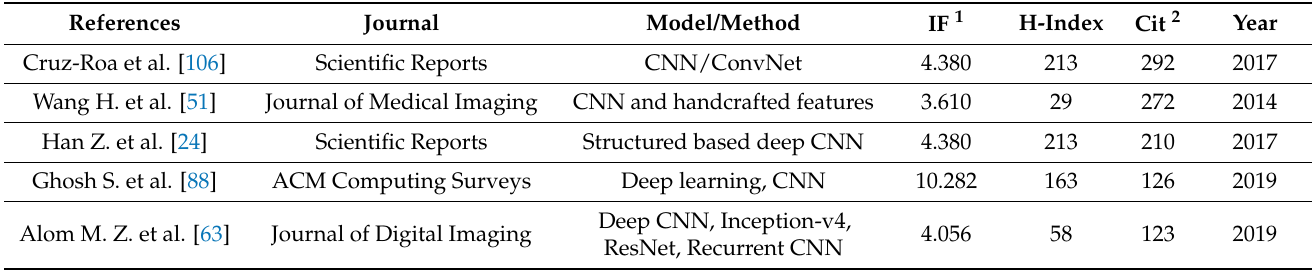
Table 7. Five references in publication in high impact journal on CNN